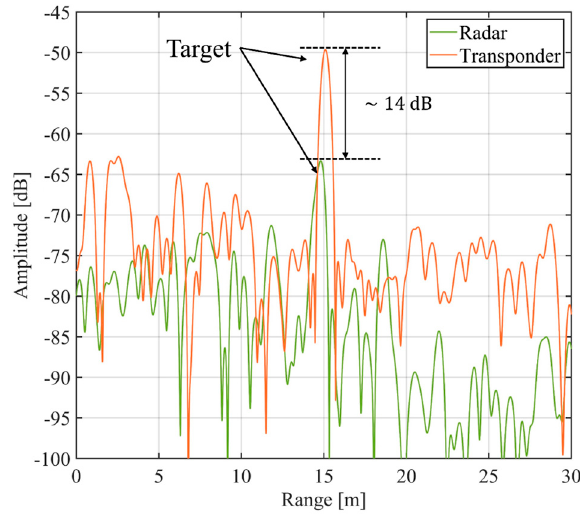
Figure 13. Amplitude image registered by radar and by transponder using the radio link.